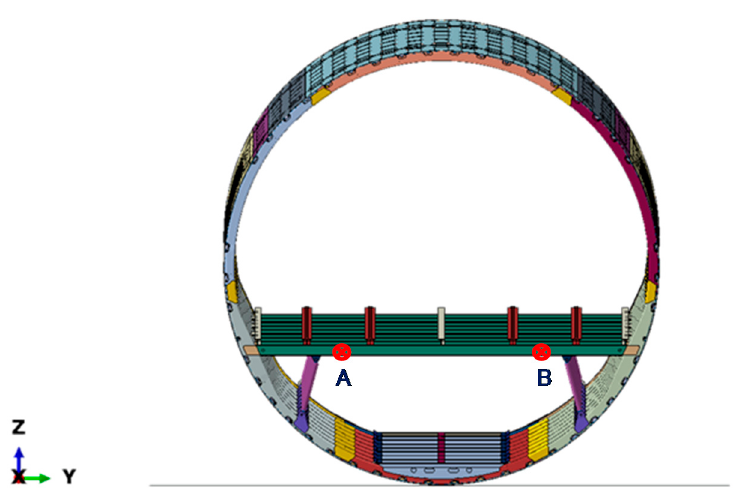
Figure 6. Point displacement positions.